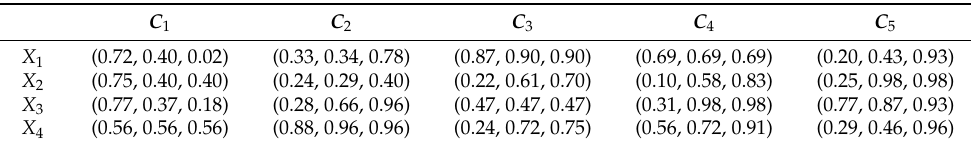
Table 4. Co-trend hesitant fuzzy decision